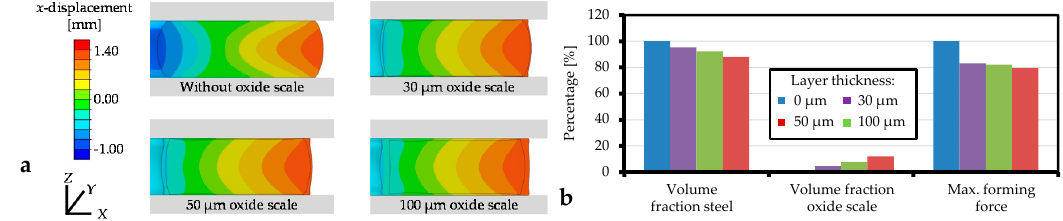
Figure 9. Final component shape and x-displacement depending on oxide scale thickness ( a ); influence of oxide scale on maximum forming force ( b ).